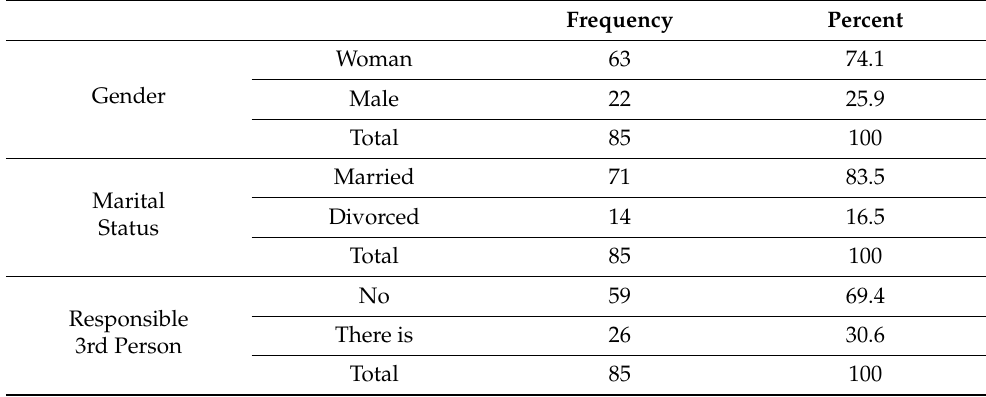
Table 1. Marital status of the parents, gender distribution of parents, and parents receiving support from a third person in the care of individuals with